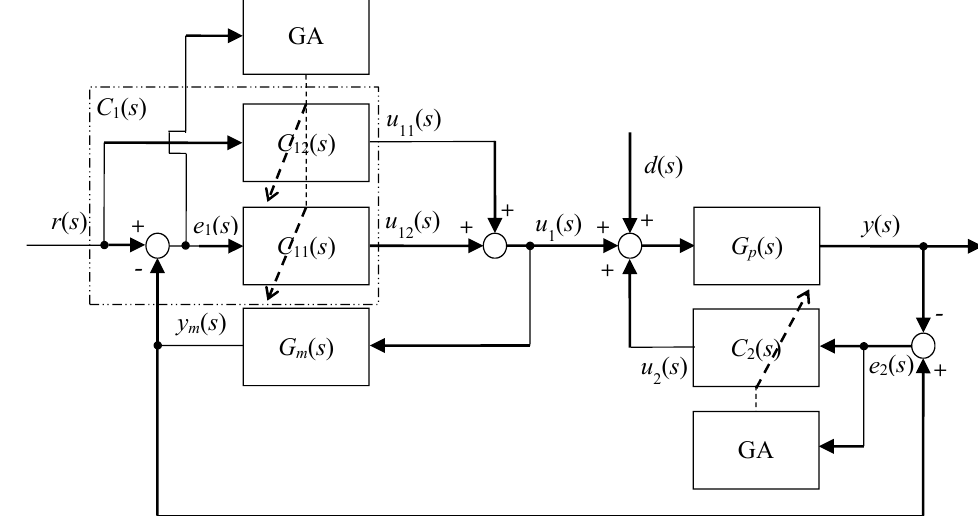
Figure 2. GA based optimal tuning in modified 2-DOF